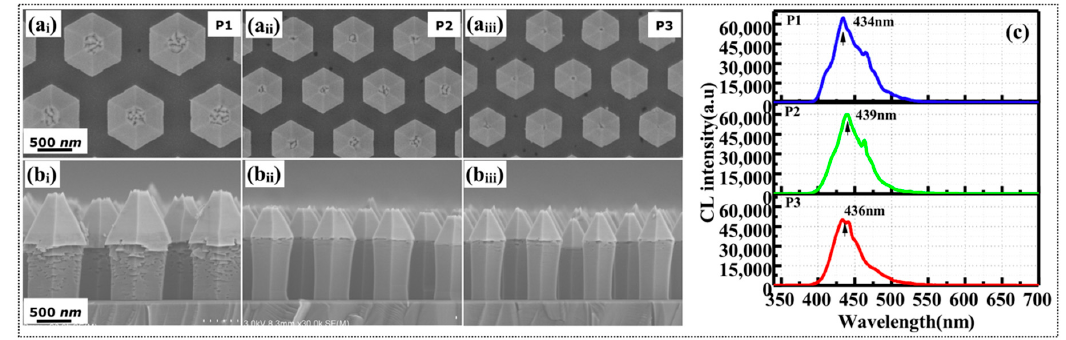
Figure 4. ( a i – a iii ) Planar and ( b i – b iii ) cross-sectional SEM images of the NW sample c formed at a barrier growth temperature of 800 °C; ( c ) CL spectra measured at the bottom areas of the NWs on